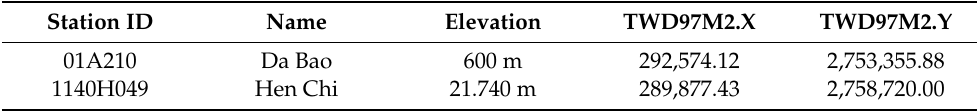
Table 1. The information of the rainfall and water level gauging